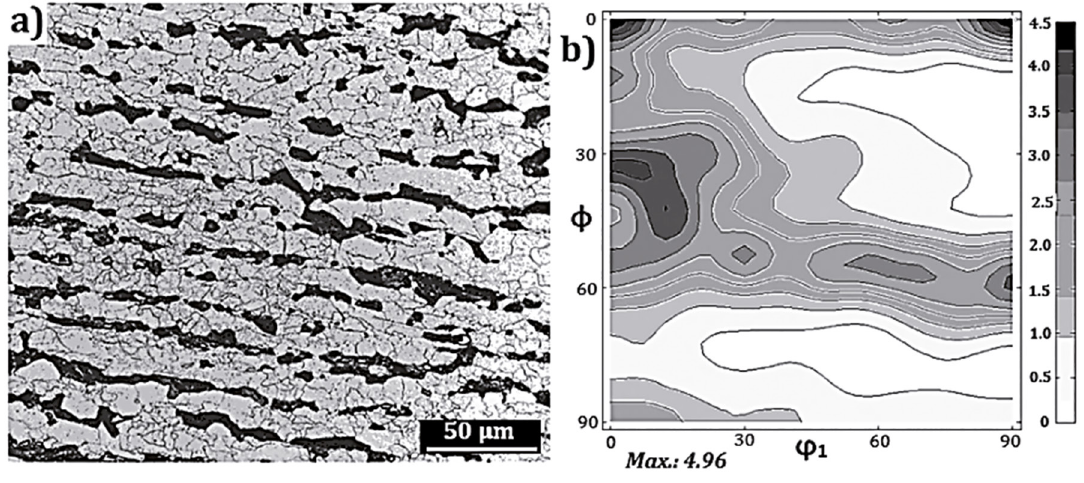
=45˚ of initial 2